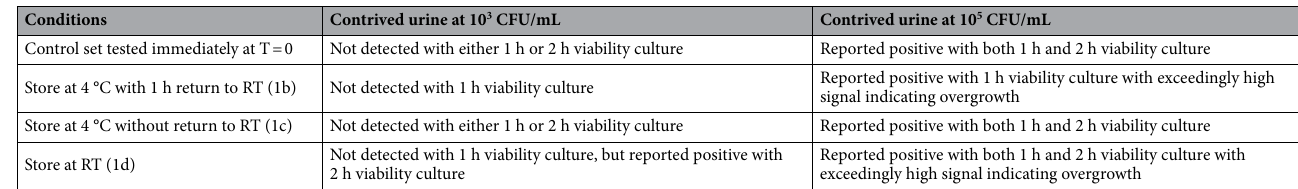
Table 2. Test conditions and pathogen detection result summary from Fig. 2.